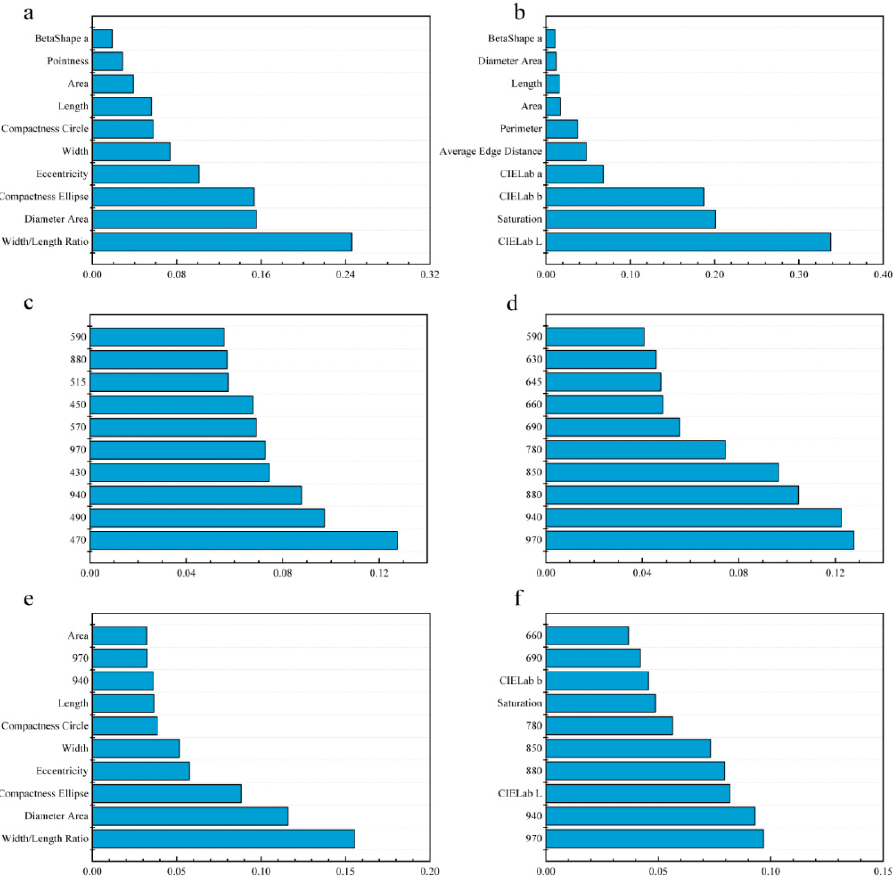
Figure 5. Relative importance of morphological, spectral and morphological combined with spectral features for LDA and support vector machine (SVM) model. ( a ) morphological features of LDA. ( b ) morphological features of SVM. ( c ) spectral features of LDA. ( d ) spectral features of SVM. ( e ) morphological combined with spectral features of LDA. ( f ) morphological combined with spectral features of SVM.